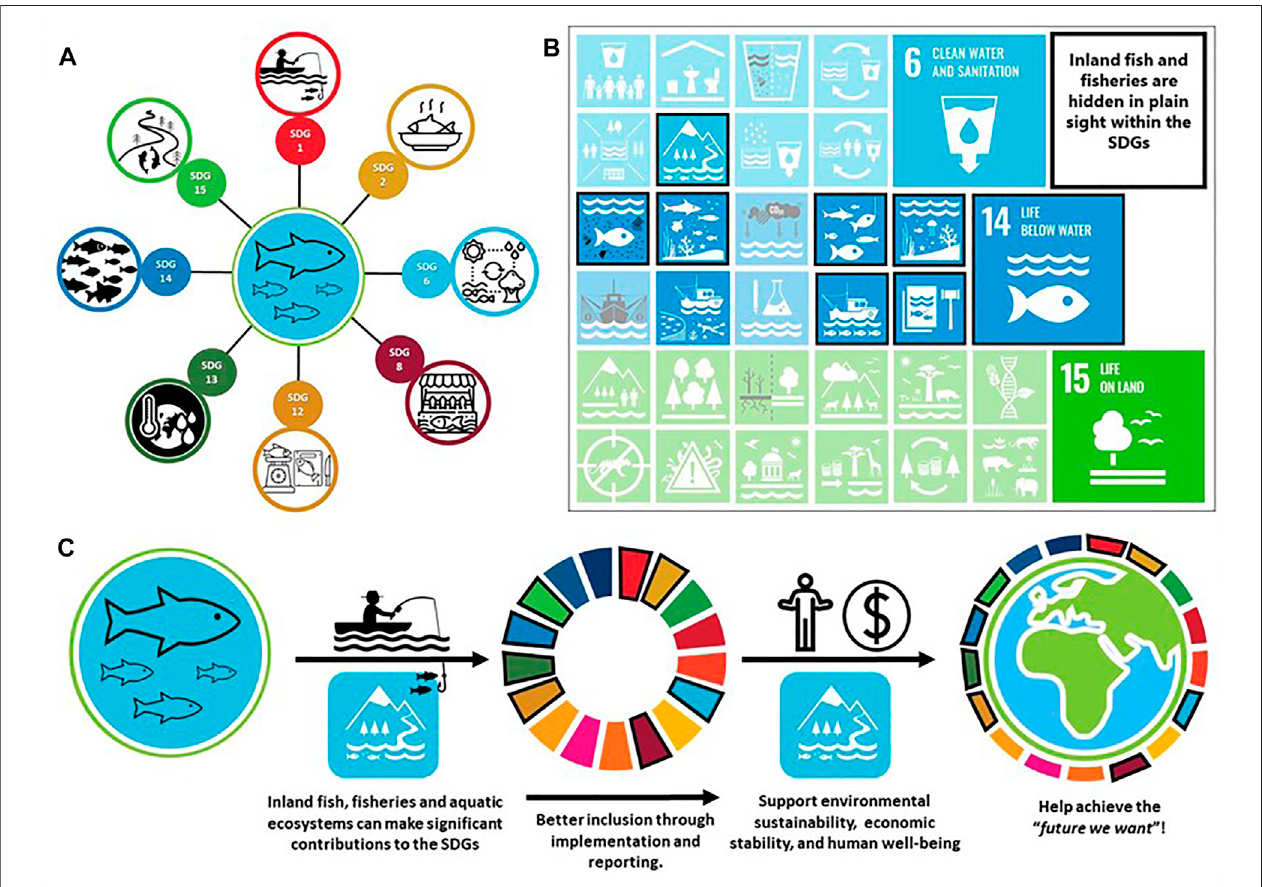
FIGURE1|(A) Inland fi sh, fi sheries,and aquaticecosystemsacrosstheglobeprovideimportantservicescontributingtoindividualSDGtargetsamongthemSDG 1:no poverty,2:zero hunger, 6:cleanwaterand sanitation, 8:Decentworkand economic growth, 12:responsibleconsumptionandproduction,13:climateaction, 14: Lifebelowwaterand15:LifeonLandandmeetingtheSDGAgendafor2030. (B) InlandaquaticecosystemservicesappearintheimageryoftheSDGssuggestinginland fi sh, fi sheries and aquatic ecosystems are well represented among these goals, when in reality they are not. There is a mismatch between the content and the imagery of the SDGs that can lead to confusion. Inland aquatic organisms are supposedly covered under SDG 15 (rows 5-6) but the icons do not represent them, by contrast fi shand fi sheriesareindicatedinthewordsandimagesassociatedwithSDG6(rows1-2);and14(rows3-4),yettheindicatorslackthescopeforincluding inland aquatic ecosystems, and for reporting on inland fi sh (https://unstats.un.org/sdgs/indicators/indicators-list/). (C) Many services from inland fi sh, fi sheries and aquatic ecosystems contribute to many of the sustainable development goals. Better management and inclusion of these resources and the services they provide through development of goals, indicators and guiding frameworks will support the economic, well-being and environmental targets of the 2030 Agenda.